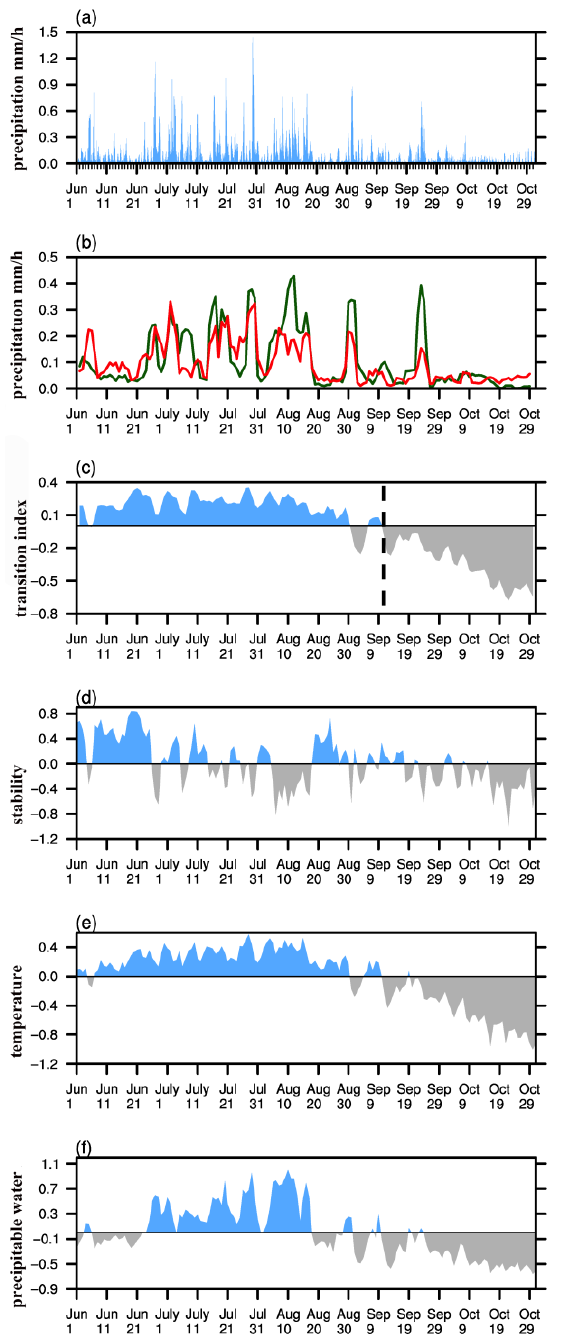
Figure A4. For June–October 2012, ( a ) hourly domain (white box in Figure 1a) averaged precipitation; ( b ) 3-day running mean of nighttime (20:00–08:00, dark green line) and daytime (08:00–20:00, red line) rainfall; ( c ) 3-day running mean of transition index anomaly (TI); normalized domain averaged ( d ) atmospheric stability anomaly, ( e ) 2 m temperature anomaly, and ( f ) precipitable water anomaly. The black dashed line in ( c ) indicates transition date 11 September 2012.